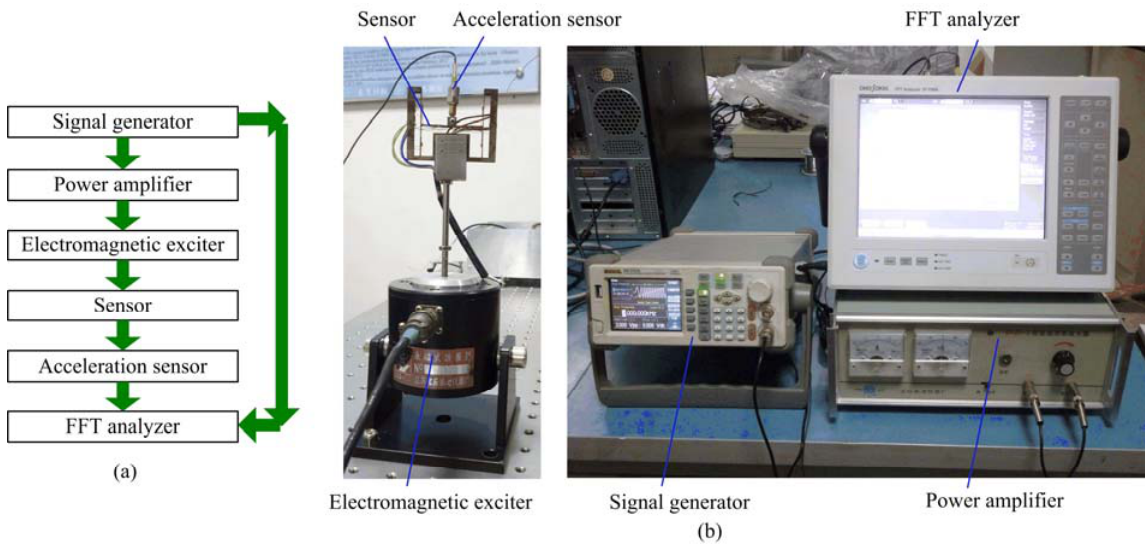
Figure 6. The experimental system.